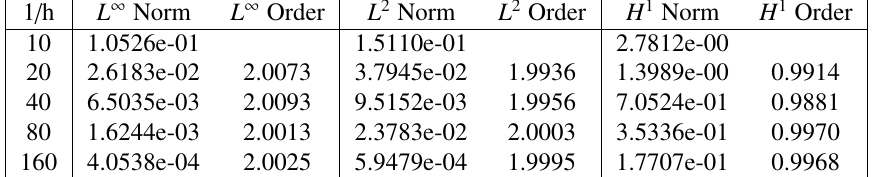
Table 5. Errors and Convergence Rate for Quadratic IFEM-CN Approximation for Example 1 Table 8. Errors and Convergence Rate for Linear IFEM-CN Approximation for Example 2